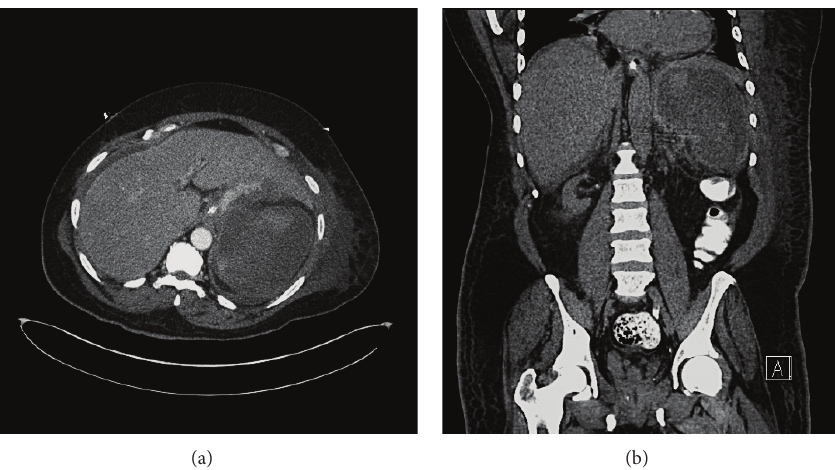
Figure 1: Contrast-enhanced computed tomographic images of the abdomen show massive splenic infarction evidenced by a diffusely hypodense spleen at presentation to emergency